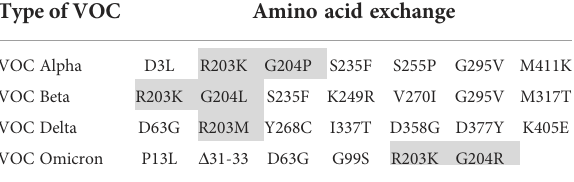
TABLE 4 Amino acid exchanges in recombinantly expressed N- proteins in comparison to the non-VOC strain (VOC de fi ning SNPs are underlined and investigated amino acid substitutions are